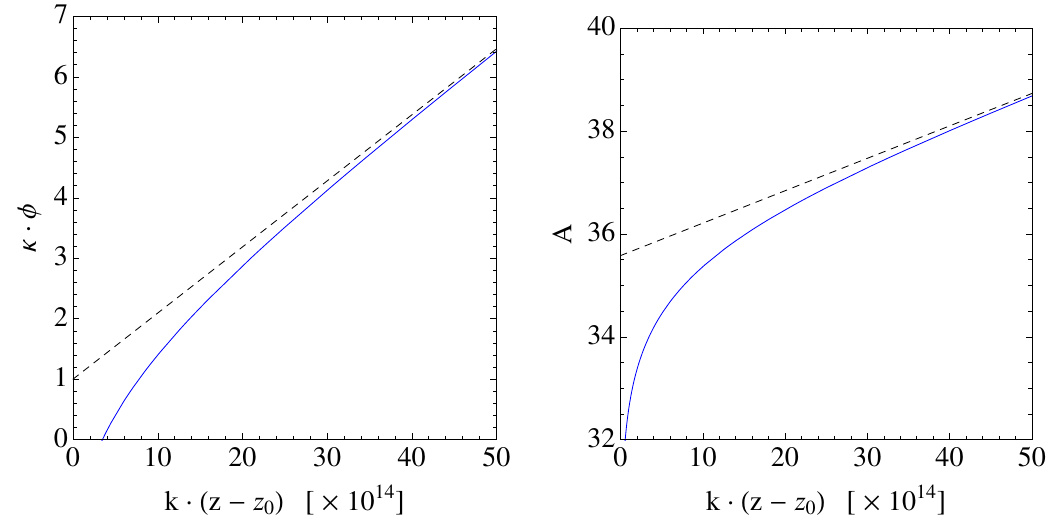
Figure 1 . Left panel: scalar (cid:12)eld (cid:30) as a function of the conformal coordinate z . Right panel: warp factor of the metric A as a function of z . We display the exact results in solid blue lines, and the linear behavior of eqs. (2.22) and (2.23) in dashed lines. We have used (cid:23) = (cid:20)= as follows by assuming A 1 = 35 and c = 1 (cf. section